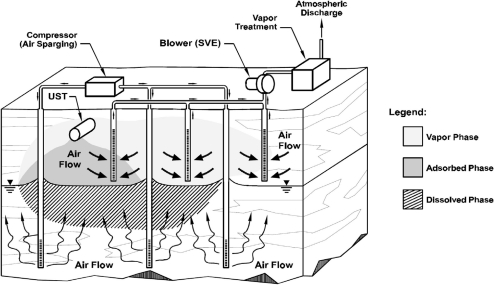
Schematic of coupled IAS and SVE remediation [4].